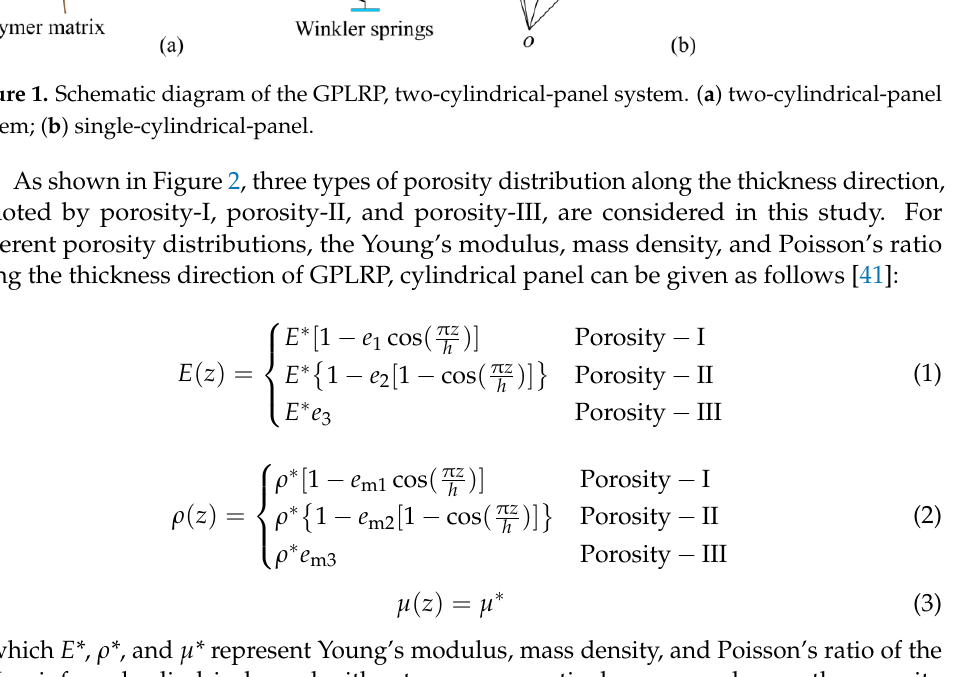
Figure 1. Schematic diagram of the GPLRP, two-cylindrical-panel system. ( a ) two-cylindrical-panel system; ( b ) single-cylindrical-panel system.